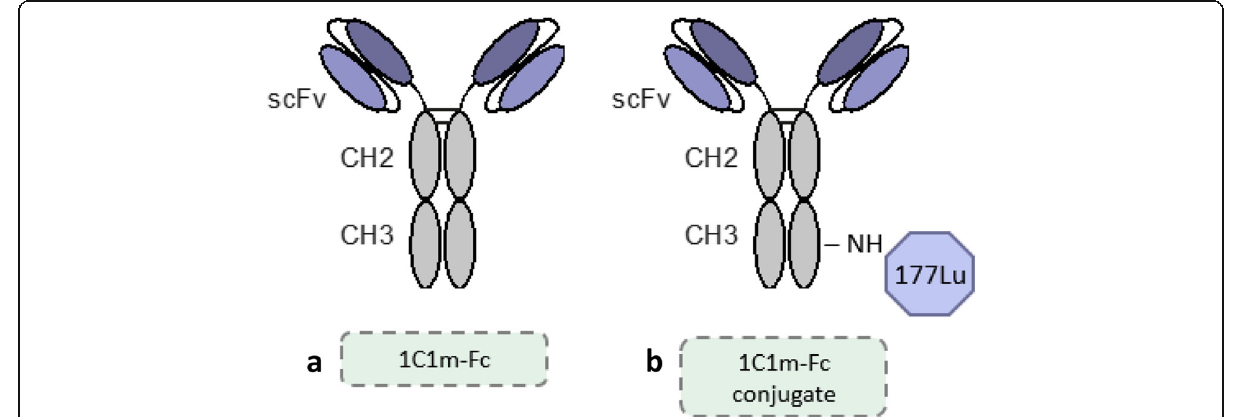
Fig. 1 Schematic figure of 1C1m-Fc ( a ) and of 1C1m-Fc conjugate radiolabeled with 177 Lu ( b